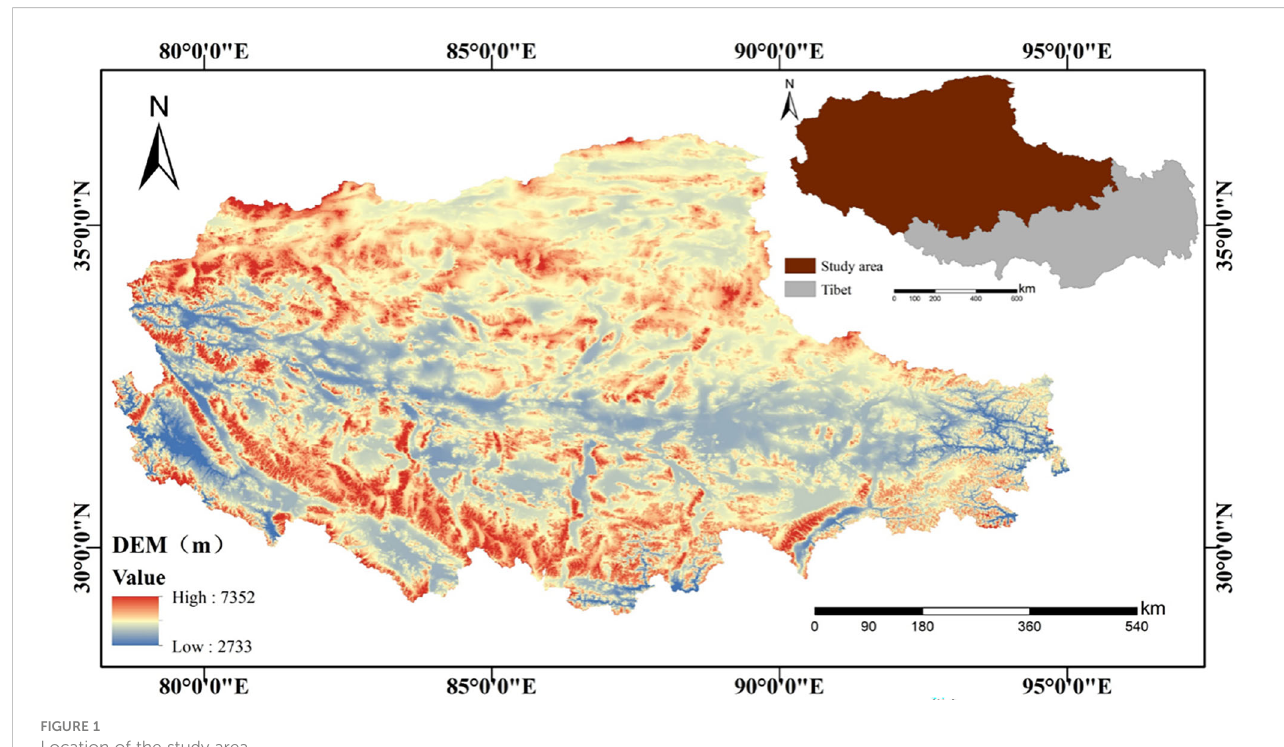
FIGURE 1 Location of the study area.